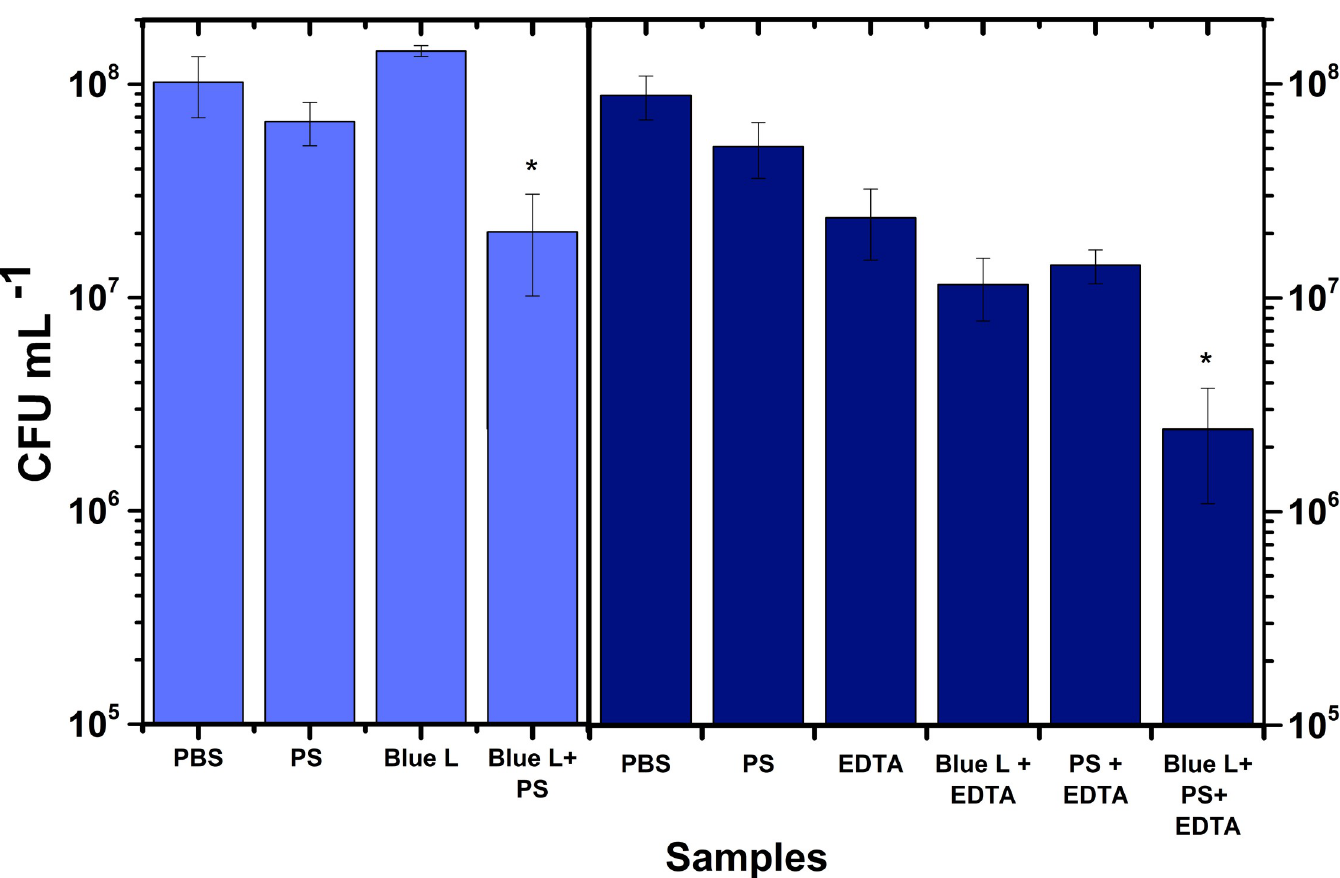
Fig 5. E . coli photoinactivation with pheomelanin nanoparticles excited with blue light with and without EDTA (10 mM). The cultures at 166 μ g/mL of pheomelanin nanoparticles were irradiated during 3 h (270 J/cm 2 ). Controls are PBS, PS, Blue light and EDTA. The strongest photoinactivation effect is depicted as Blue L+PS+EDTA. Values are averages and standard deviations of three biological triplicate. � p <